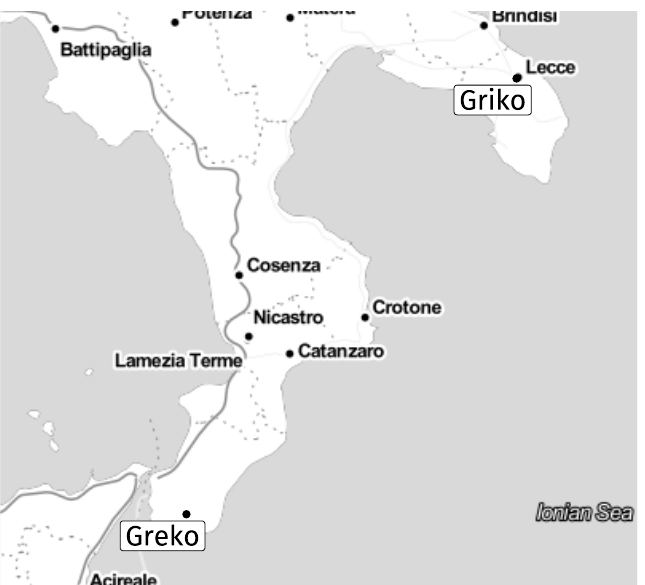
Figure 1. Map indicating the approximate location of the speech areas of Greko and the Salentine Greek variety Griko (glottocode apul1237) in southern Italy. The map was generated using R (v. 4.2.0; R Core Team 2022) and RStudio (v. 2022.02.3; RStudio Team 2022) using the packages ggplot2 (v. 3.3.6; Wickham 2016) and ggmap (v. 3.0.0; Kahle and Wickham 2013). The script is available as supplementary material